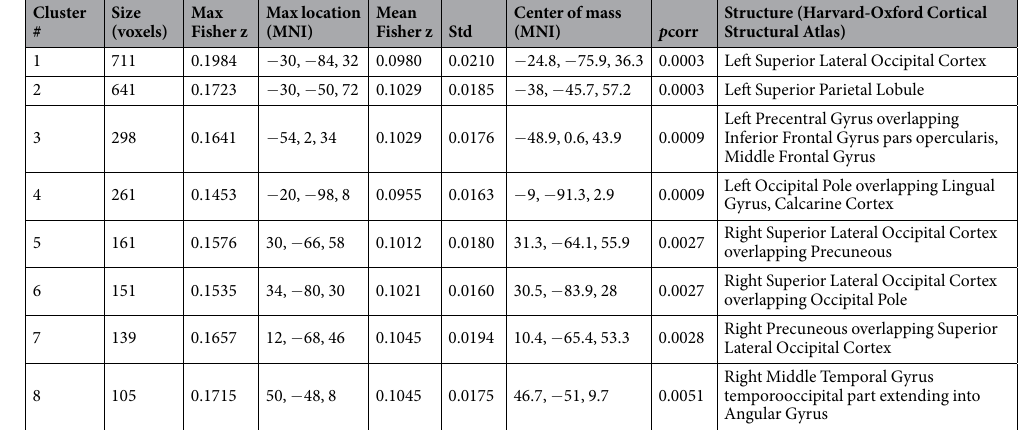
Table 1. Clusters from the cue period that showed significant correlated activity patterns with the dimension- weighted model.